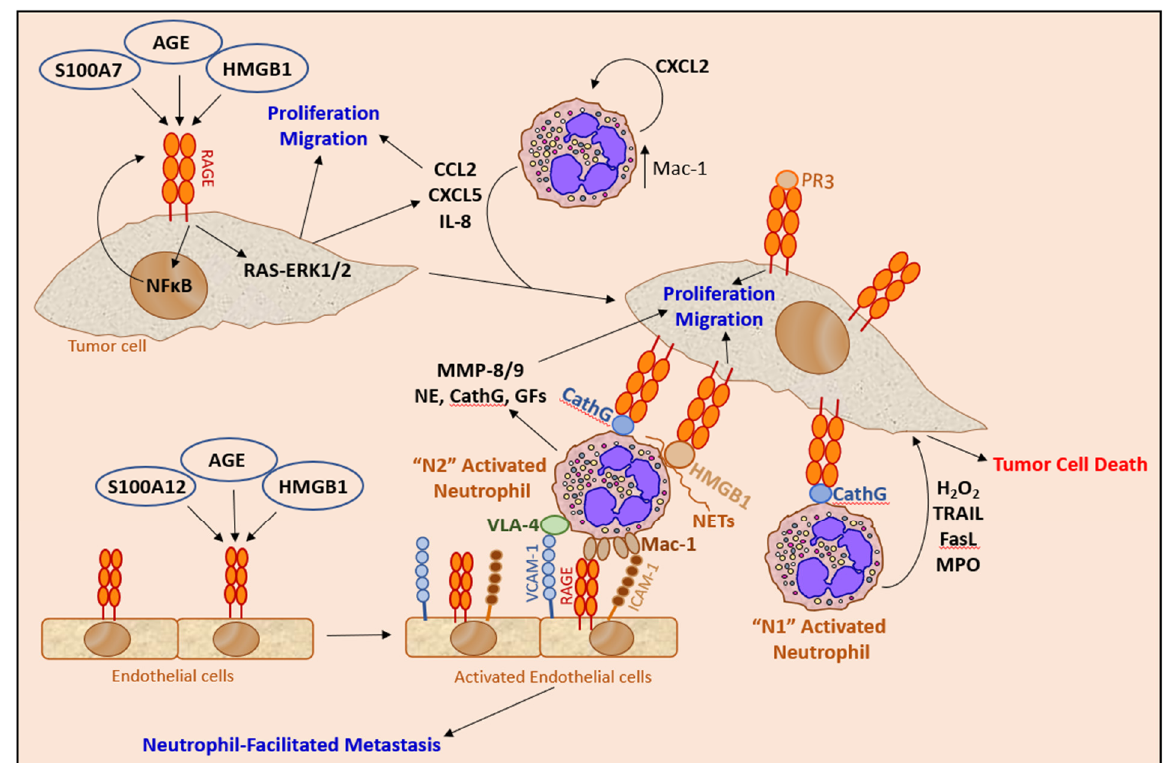
Figure 7. The two faces of the RAGE-Cathepsin G interaction in neutrophil tumor biology. Interaction of RAGE ligands with RAGE on tumor cells leads to proliferation and migration of the tumor cells, as well as the secretion of chemokines that attract and activate neutrophils. The neutrophils can be activated to either anti-tumor “N1” neutrophils or pro-tumor “N2” neutrophils. The interaction of neutrophil-expressed CathG with RAGE on tumor cells facilitates neutrophil-mediated killing of tumor cells. The killing of tumor cells requires simultaneous production of cytotoxic molecules, such as H 2 O 2 , TRAIL, FasL and OCl − produced from H 2 O 2 by MPO. However, when the tumor cell-interacting neutrophil is alternatively activated to the “N2” phenotype that does not kill the tumor cells, the interaction of neutrophil-expressed CathG with RAGE on tumor cells strengthens the immunological synapse together with other neutrophil–tumor cell interactions (confer Figure 5). Simultaneous interaction of the neutrophils with endothelial cells facilitates the metastatic seeding of the tumor cell into the distant organ. Endothelial RAGE and ICAM-1 interact with Mac-1 (CD11b/CD18) on neutrophils, and endothelial VCAM-1 interacts with α 4 β 1 (VLA-4) on neutrophils. It is still unknown whether CathG on neutrophils can interact with RAGE on endothelial cells. CathG = Cathepsin G, NE = Neutrophil elastase, and GFs = Growth factors.